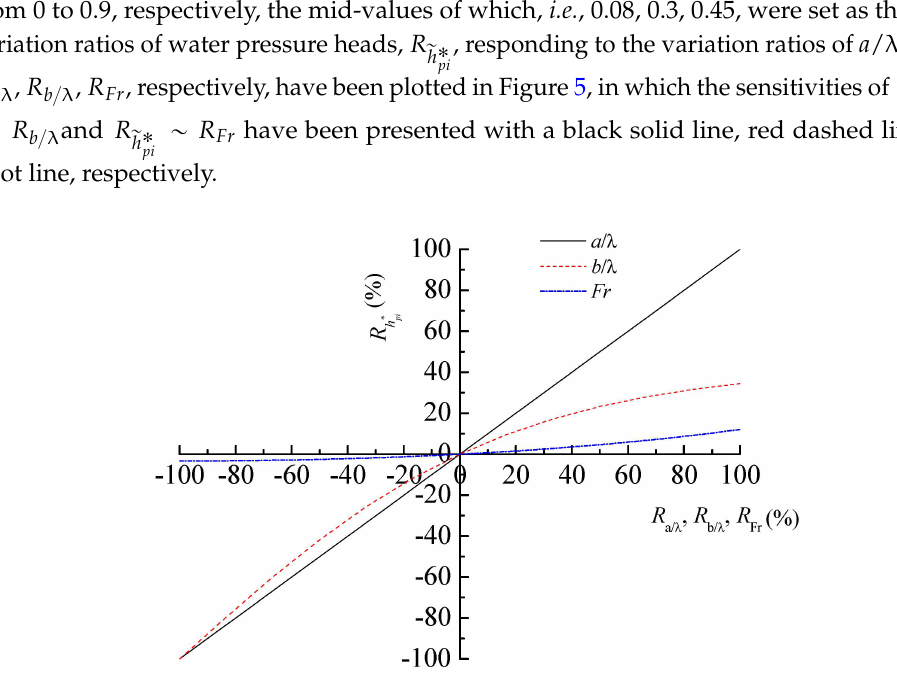
Figure 5. Sensitivity of the variation of water pressure head to that of a / λ , b / λ and Fr . The horizontal axis presents the variation ratios of a / λ , b / λ and Fr , while the vertical axis is the variation ratio of the water pressure